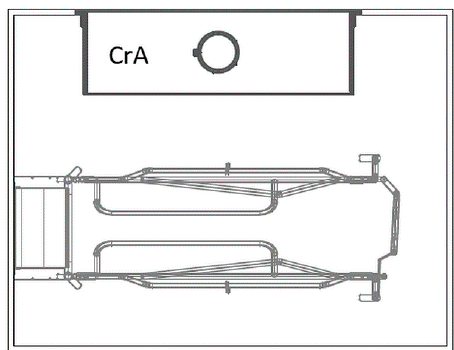
Figure 1. Pen with farrowing crate (FC). CrA = creep area. © Big Dutchman International GmbH, Vechta, Germany.